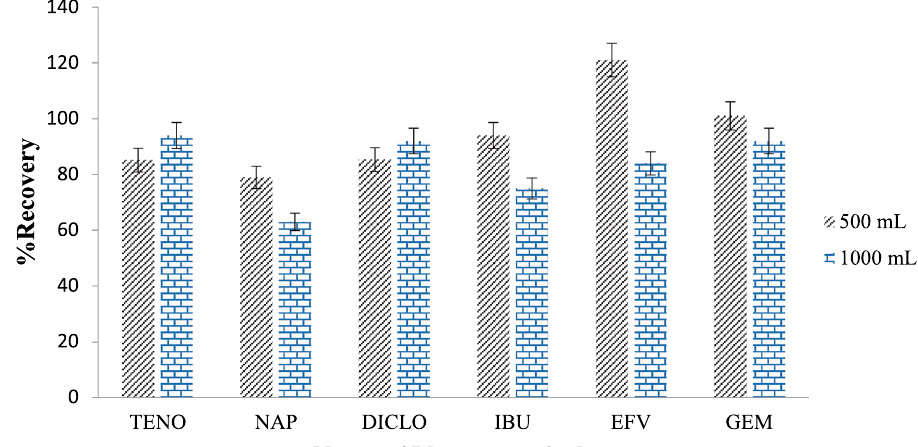
Fig. 3 The effects of sam- ple volume on percentage recovery